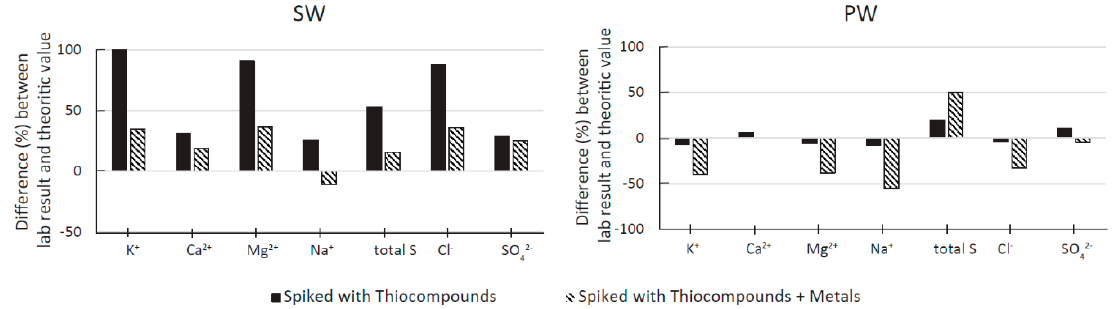
Figure 5. The difference (expressed in %) between the analysis of spiked waters and non-spiked water.